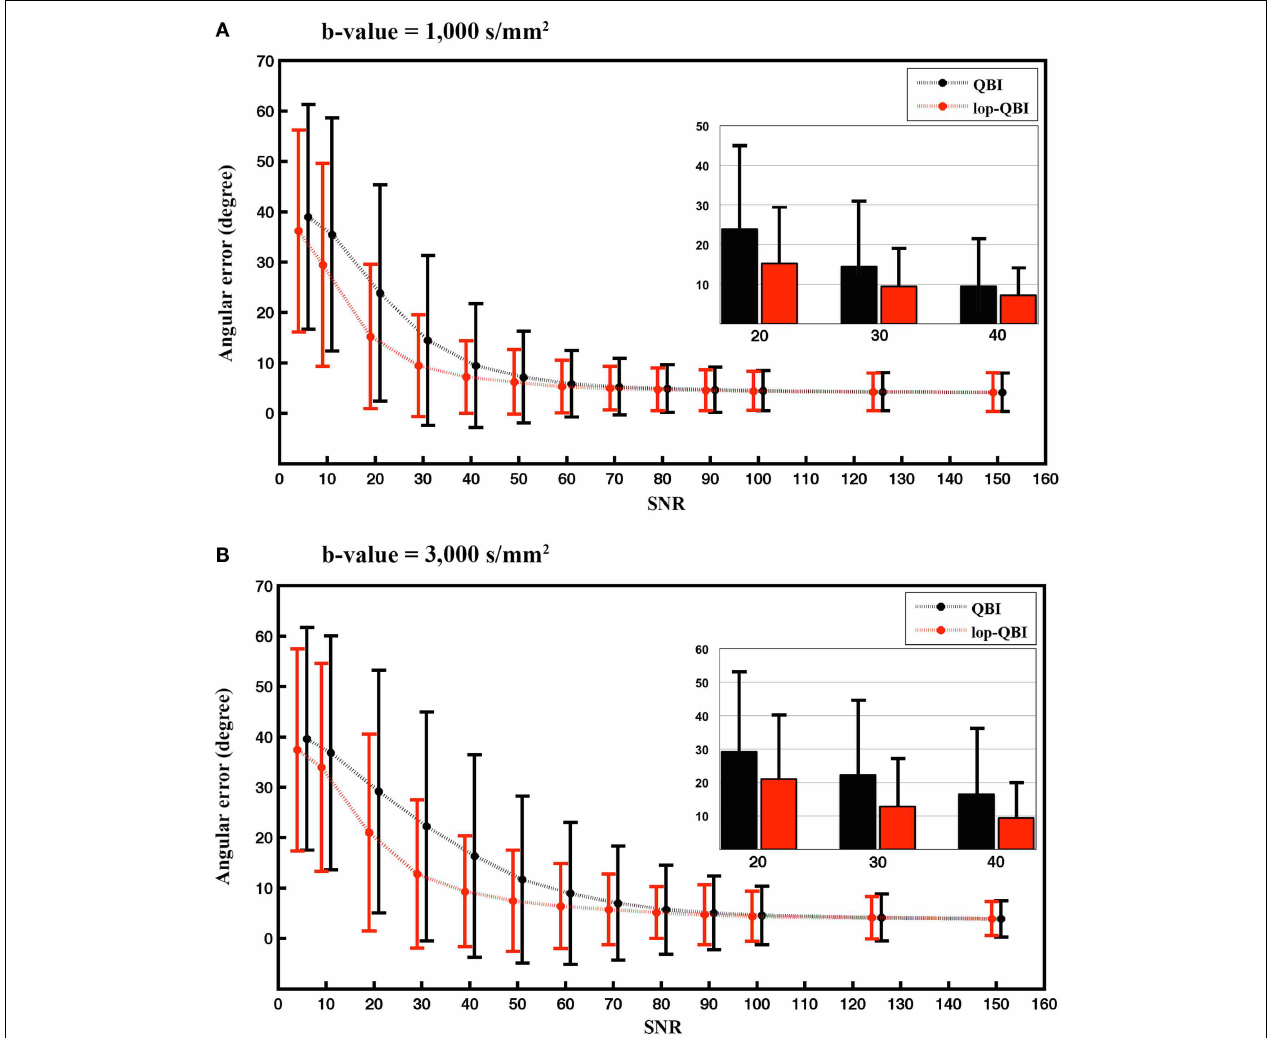
visualization, mean and SD of angular error for SNRs of 20, 30, and 40 are illustrated separately inside each plot. In (A) , all the mean differences ≤ 50 are statistically significant. In (B) , all the mean differences ≤ 70 are statistically significant ( p < 1e −